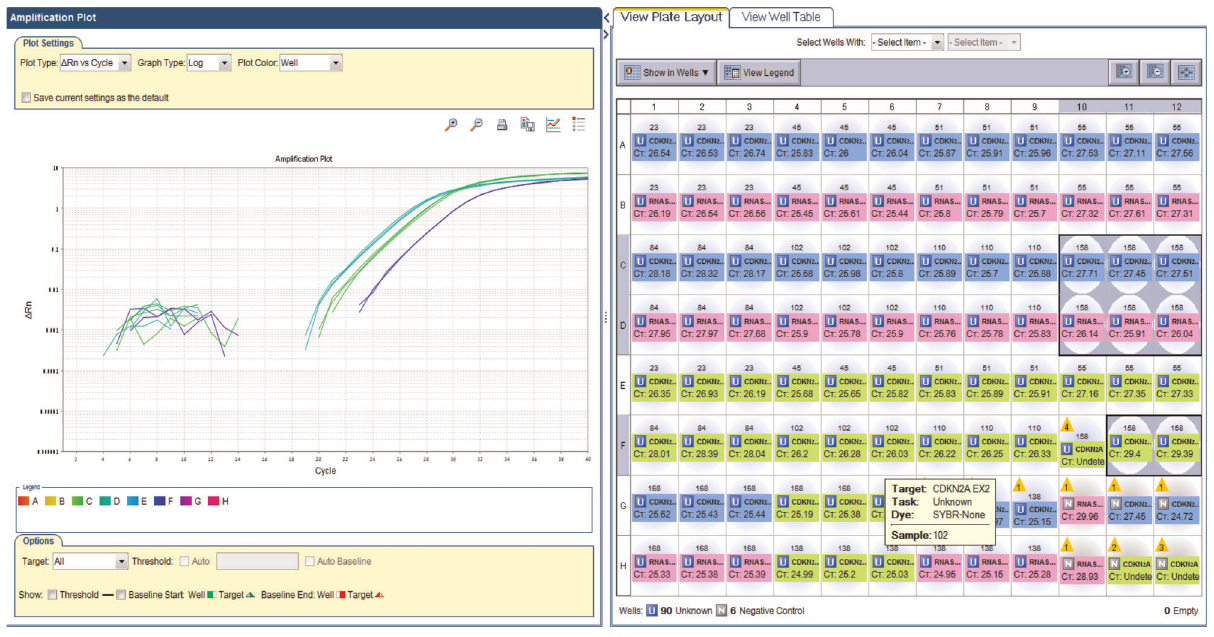
FIGURE 1 | CDKN2A plot. A deletion was detected in exon 1 and exon 2 of CDKN2A in one sample (no. 54) of pleomorphic xanthoastrocytoma. RTPCR plot, showing Reference gene RNaseP - 26 Ct. Please note CDKN2A Exon 1 – 27 Ct (middle green) and CDKN2A Exon 2 – 29 Ct (right blue). A ratio of <0.5 was considered a